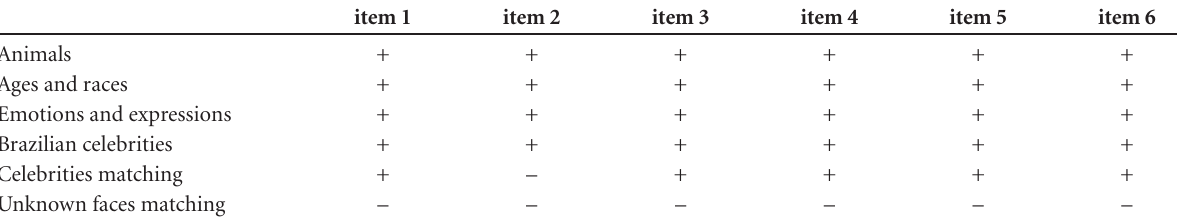
Table 2. Results on visual recognition and face recognition